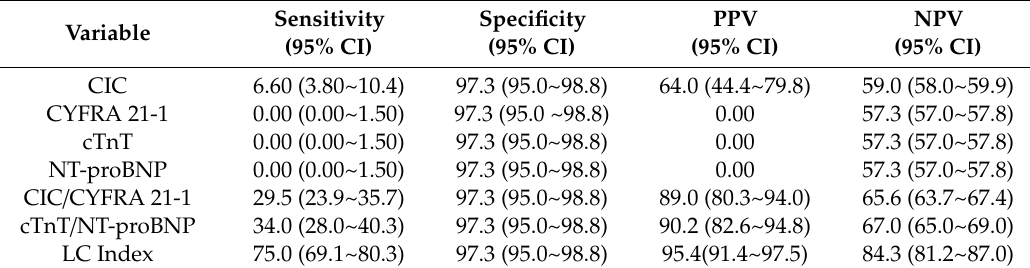
Table4. Clinicale ffi ciencyintermsofsensitivity, specificity, PPV,andNPVofLCindexfordiscrimination of healthy individuals ( n = 359) and cancer patients ( n =